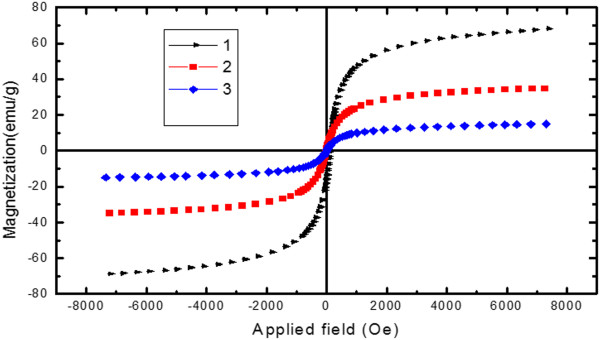
The magnetic behavior of magnetic nanoparticles. (1.Fe3O4, 2. VTES-Fe3O4, 3. VTES-Fe3O4-PNIPAAm-MAA).